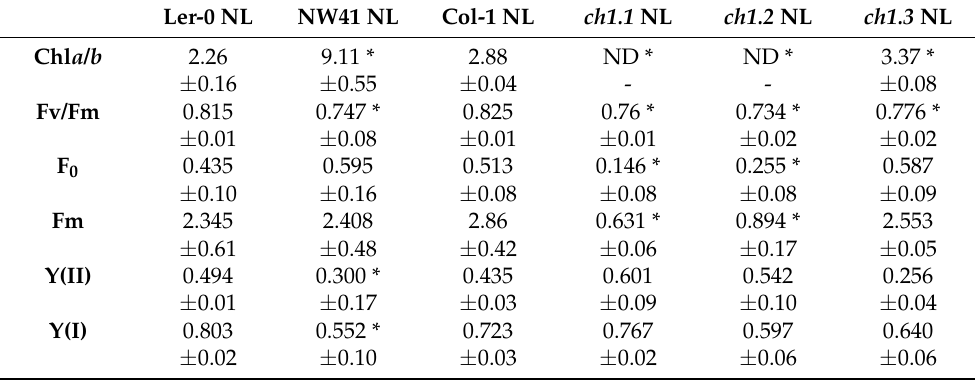
Table 1. Chlorophyll fluorescence analysis of wild-type and ch1 mutants. NL—normal light condi- tions, 110 µ E. The data are mean values ± SD from 3–4 independent experiments. ND—the amount of chlorophyll b was below a reliable level for the method used, hence the absence of the Chl a / b ratio. Ler-0 NL NW41 NL Col-1 NL ch1.1 NL ch1.2